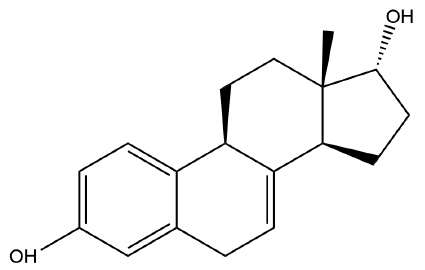
Figure 1. The molecular structure of 17 α -dihydroequilin.